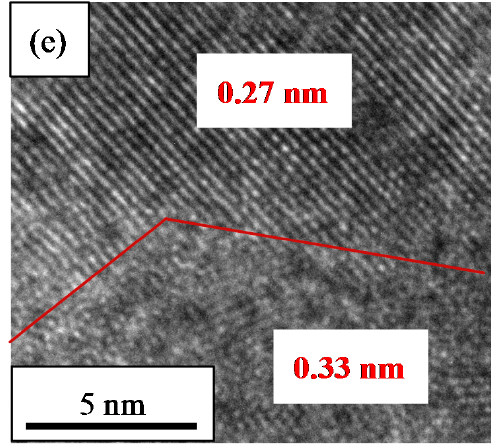
Figure 1. FESEM images with 100 k magnification: ( a ) ZnO; ( b ) 0.25 at % TiO 2 -ZnO; ( c ) 0.50 at % TiO 2 -ZnO; and ( d ) 1.0 at % TiO 2 -ZnO; ( e ) HRTEM image for TiO 2 -ZnO.